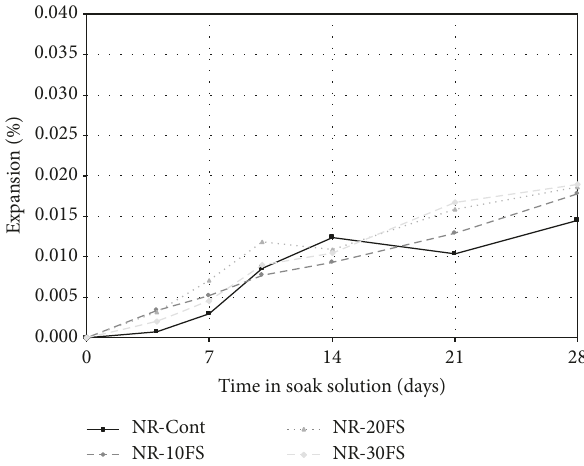
Figure 3: Expansion curves of manufactured (nonreactive) sand: foundry sand mixtures.